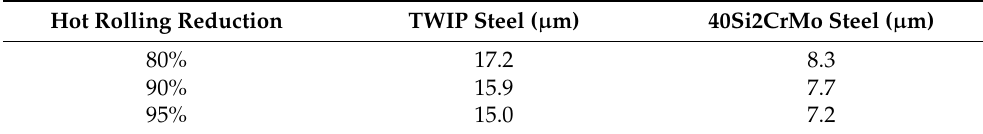
Figure 4. The microstructures of TWIP, 40Si2CrMo, and the multilayer steels with three hot rolling reductions: ( a ) TWIP steel; ( b ) 40Si2CrMo steel; ( c , d ) the reduction is 80%; ( e , f ) the reduction is 90%; ( g , h ) the reduction is 95%. RD: Parallel to the rolling direction; ND: Perpendicular to the rolling direction. Table 2. Grain sizes of the constituent layer of multilayer TWIP/40Si2CrMo steel with three hot reductions.